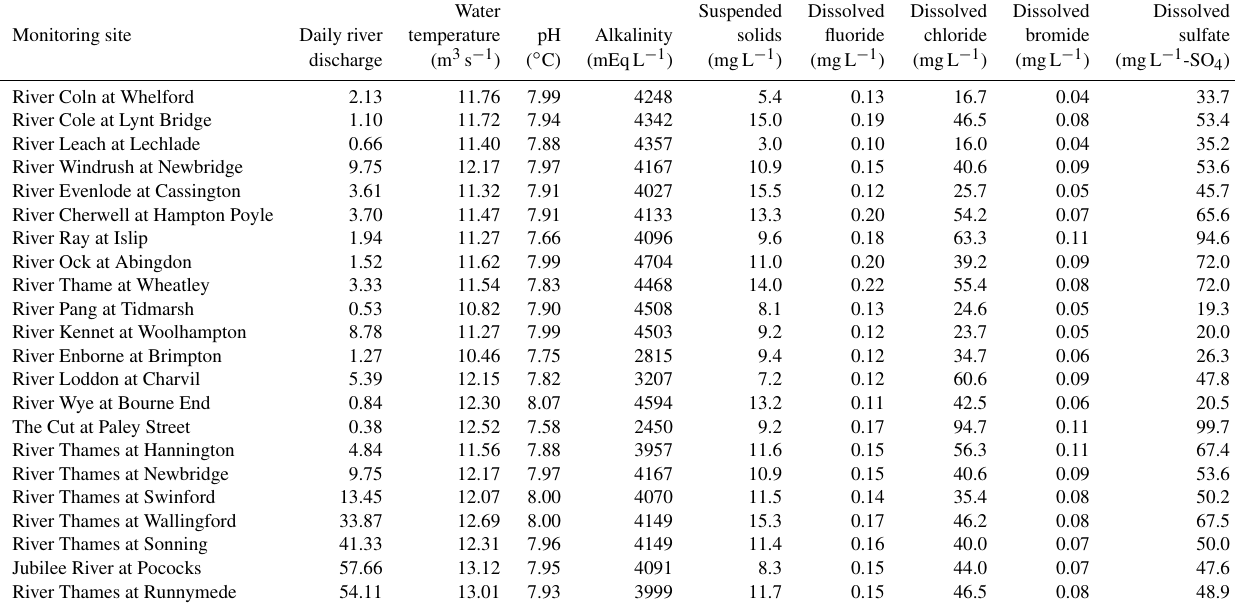
Table 2. Mean water quality data from March 2009 to February 2013. Water